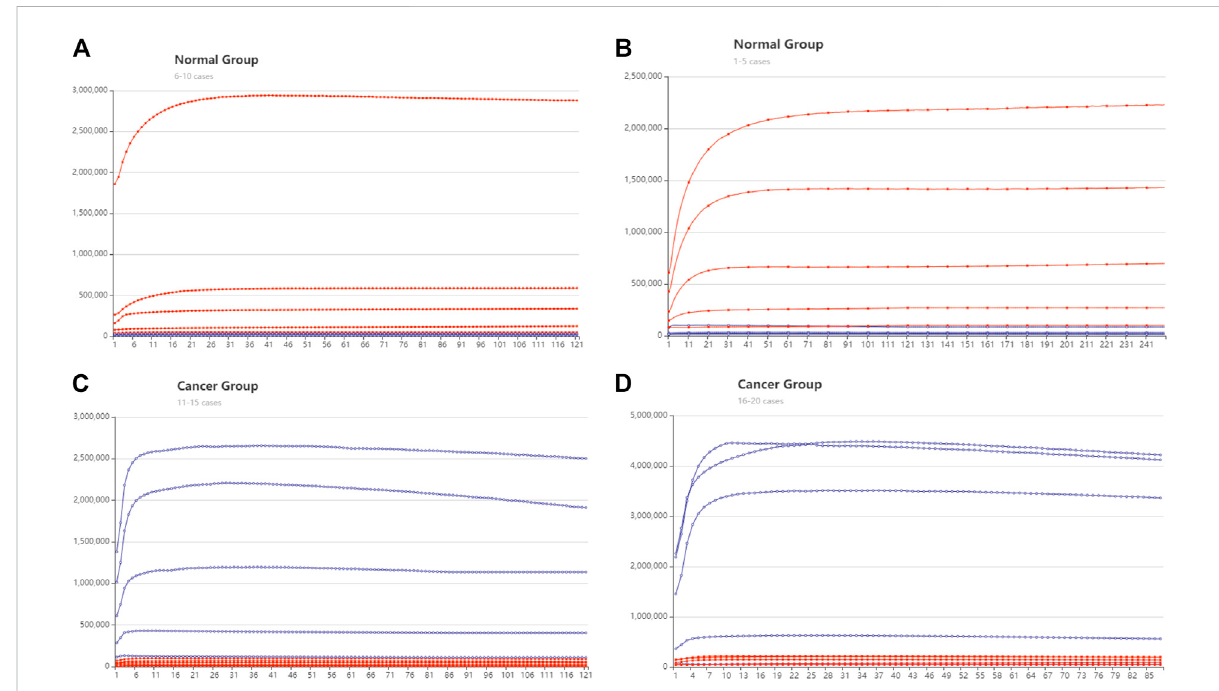
FIGURE 5 DNAcomputingwith fl uorescentsignalresults.TheredlinesrepresentthetrajectoryofROXmodi fi edsignal,andthebluelineisthetrajectoryof theFAMsignal.The y -axis isFluorescent intensity, X axis isthecyclenumber,10 sisonecycle (A) The normal groupcases 1 – 5. (B) The normal group cases 6 – 10 (C) The cancer group cases 11 – 15. (D) The cancer group cases 16 –